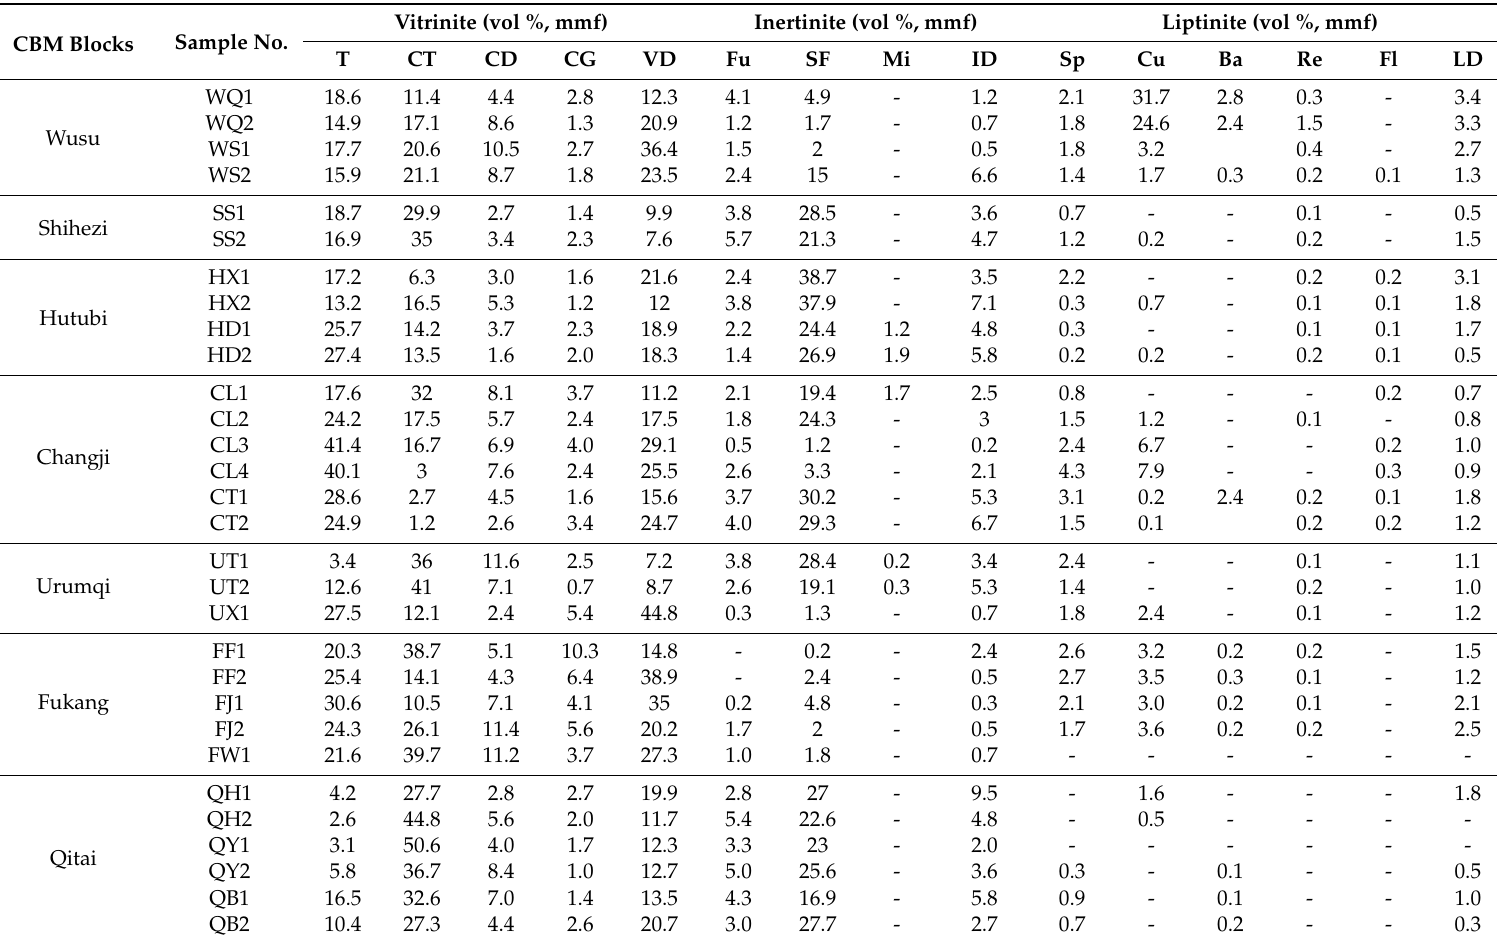
Table 1. Maceral compositions of Middle Jurassic coals in coal seam No. 45 from the southern Junggar Coalfield, NW China.